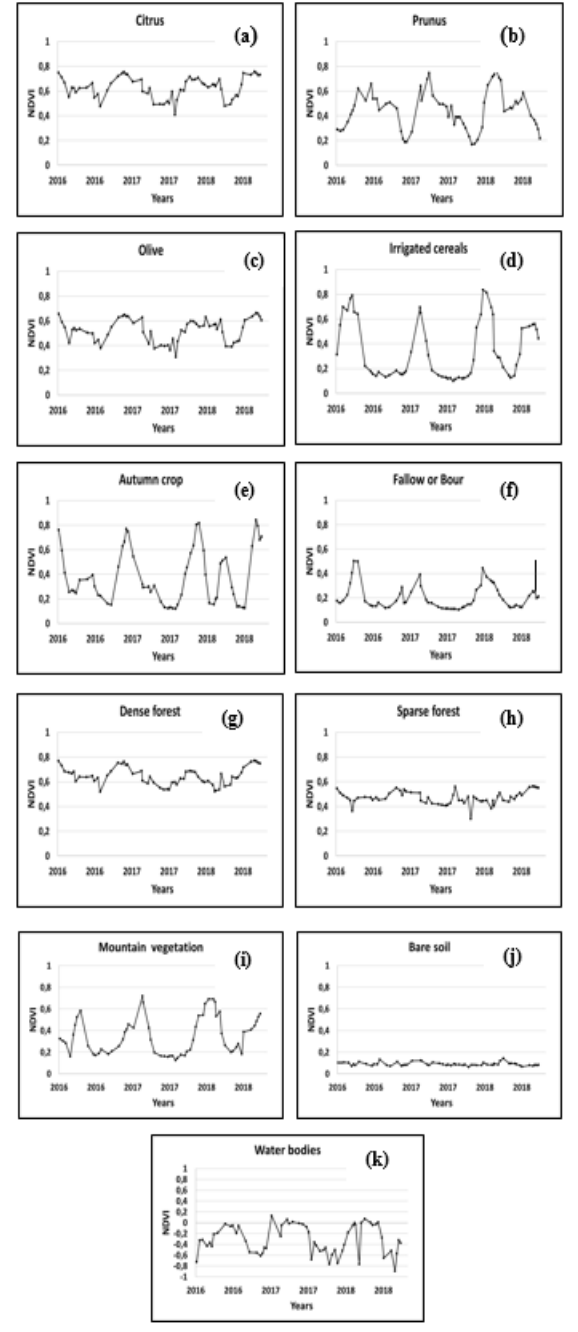
Figure 2. NDVI Temporal patterns behaviors of the chosen classes in the study area, over a three-years period. For overlaying and reading problems mountainous classes profiles were plotted apart, also ‘Bare soil’ and ‘Water bodies’ classes were not presented in the graphs, for being relatively easy to spot compared to the rest throughout the year, as they respectively present near null and negative NDVI values. When looking at the annual evolution of the curves, we notice the presence of three critical periods for the Spectro-temporal separation of the classes, and the set of the optimal thresholding values: